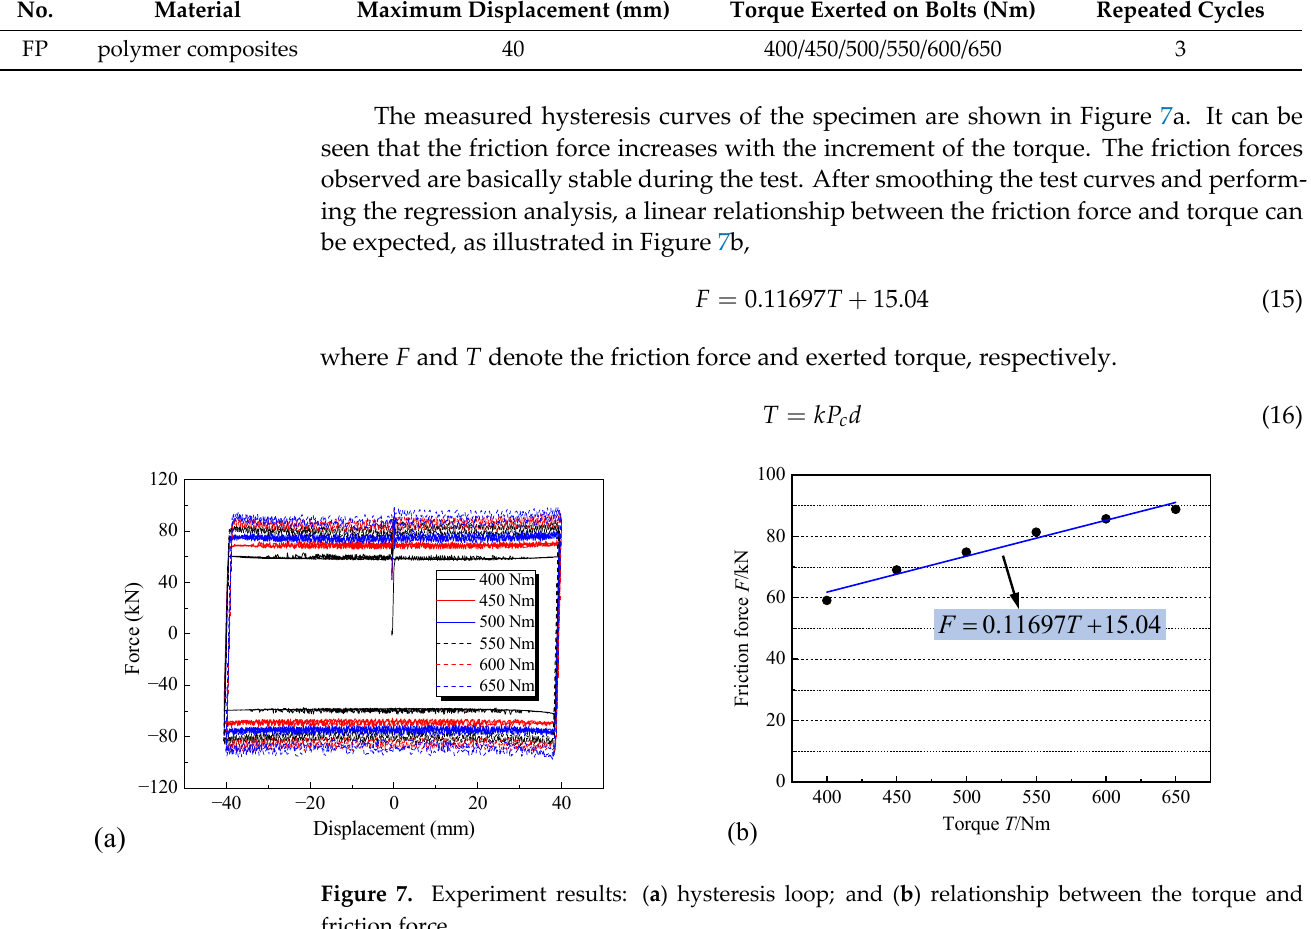
Figure 7. Experiment results: ( a ) hysteresis loop; and ( b ) relationship between the torque and friction force.